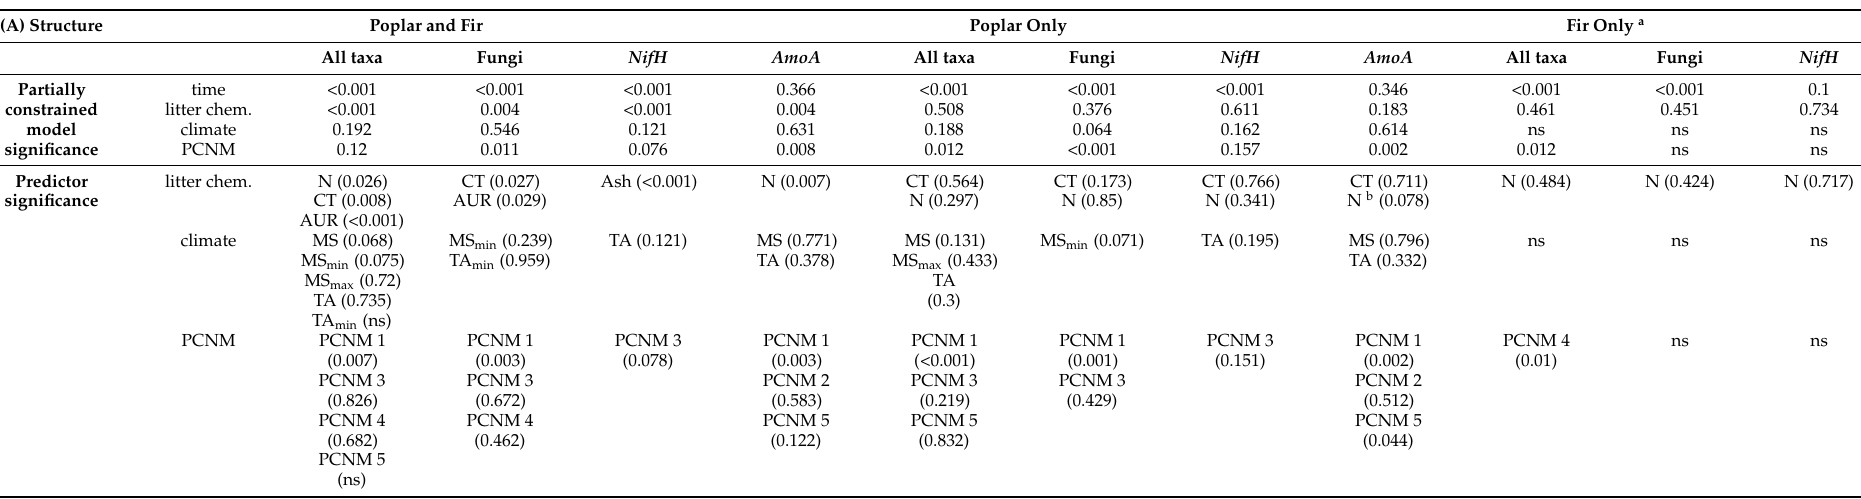
Table 4. Significance ( p -values) of continuous models and predictors in predicting microbial community structure ( A ; Shannon’s diversity, richness and Pielou’s evenness) or composition ( B ; presence/absence). Partially constrained ordination analyses were used to test the effects of continuous time, initial litter chemistry, climate or principal coordinates of neighbor matrix (PCNM) predictors, while removing other respective effects. Climate and PCNM variables (and litter chemistry in the case of joint poplar and Fd analyses) were first reduced until only significant predictors remained ( α -level = 0.05). Cases where no variables were deemed significant and when all of the variance accorded to a variable is confounded by partial constraints are labeled by ‘ns’. Data from poplar and Douglas-fir litter were treated separately (poplar only and fir only, respectively) and jointly (poplar and fir). Fungi, AmoA and NifH functional groups were also treated separately and jointly (all taxa). The column for AmoA is not included when using only Fd data since this gene was never detected in this litter type. Mean annual range in soil temperature is designated ‘TS range ’. Refer to Tables 1 and 2 for other abbreviation